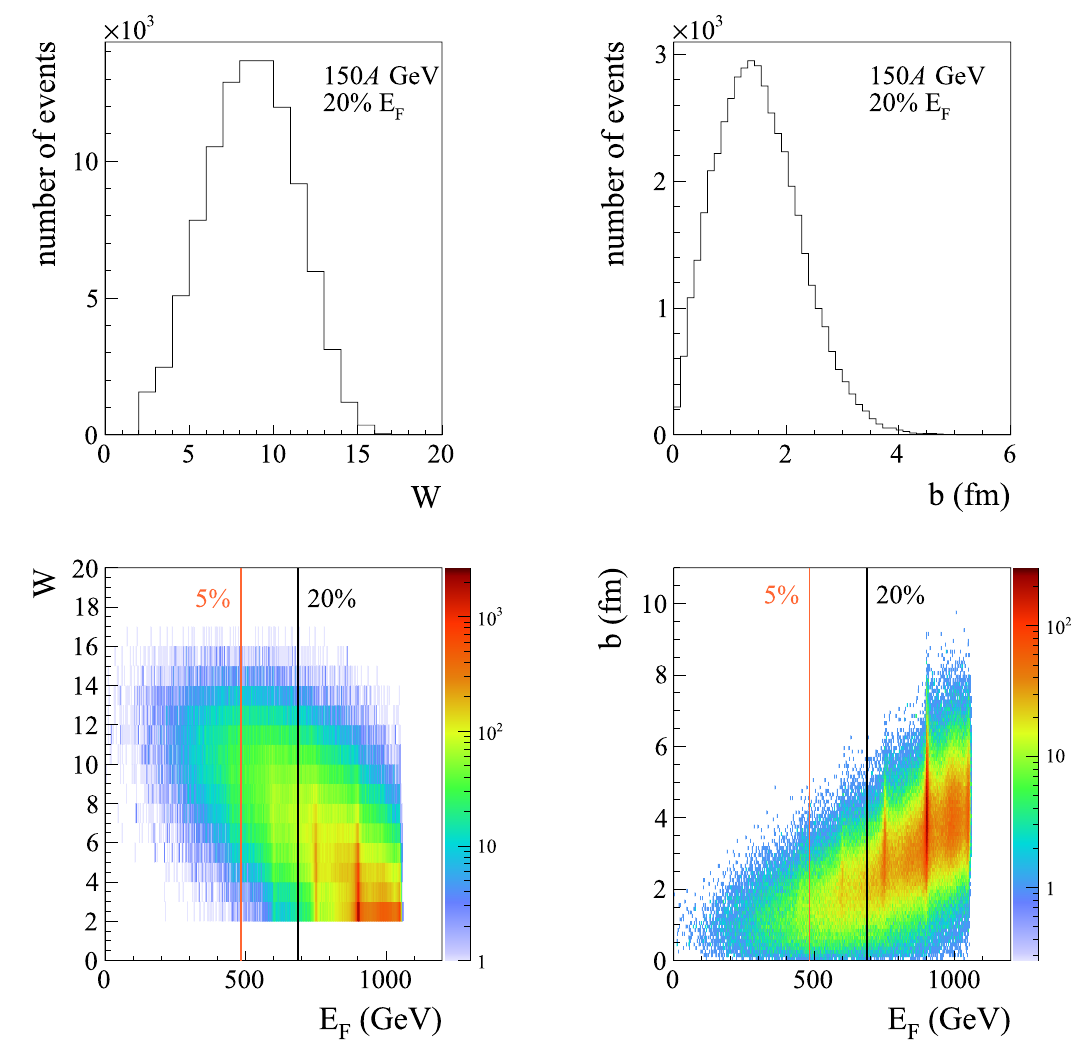
Fig. 4 Examples of the distribution of the number of wounded nucleons W (left) and collision impact parameter b (right) for events with the 20% smallest forward energies E F (central) at beam momentum of 150 A GeV / c simulated with the Epos model using the acceptance map provided in Ref.